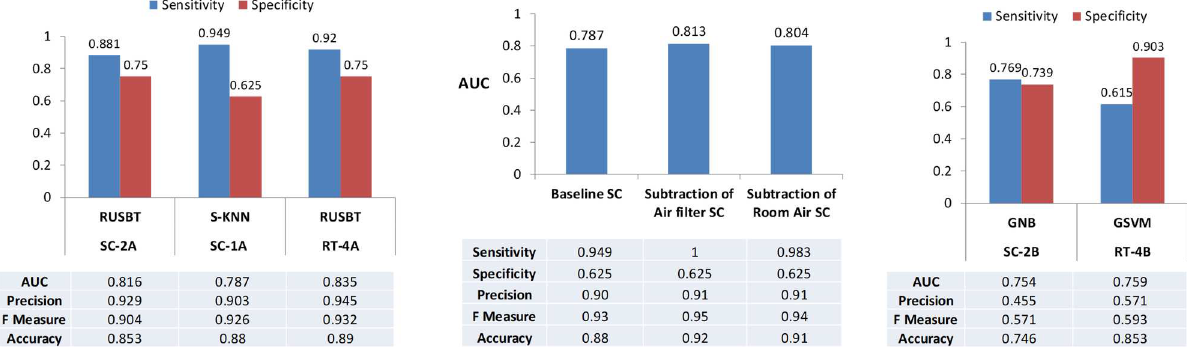
Fig 5. Performance of volatolomic models for the detection of cirrhosis. Volatolomic classifier algorithms were generated by machine learning based analysis of time resolved separation chromatograms (SC). (A.) Classifiers were generated for the detection of cirrhosis. Models were trained on a random set of samples from 24 patients, and the exported models’ performance was assessed in an independent validation set of samples from the remaining patients. The sensitivity and specificity of models based on random under-sampling boosted trees (RUBST) or Subspace K nearest neighbors (SKNN) are shown along with performance characteristics for each model. (B.) Effect of environmental volatile compounds on performance of models for the detection of cirrhosis. Volatolomic classifiers were generated from analysis of baseline chromatograms, or after subtraction of concomitantly collected air-filter or room-air blank sample data. (C.) Classifiers were generated for the detection of decompensated disease (Stage 3) in persons with cirrhosis alone–Model SC-2B using Gaussian Na ï ve Bayes (GNB), or in the persons with cirrhosis or non-cirrhotic portal hypertension– Model RT-4B using Medium Gaussian support vector machines (GSVM). These models were trained on a random set of samples from 18 liver disease patients, and performance was assessed in an independent validation set of samples from 17 patients for SC-2B or 21 patients for RT-4B. The sensitivity and specificity of models are shown along with performance characteristics for each. AUC: area under the receiver operator characteristic curve.